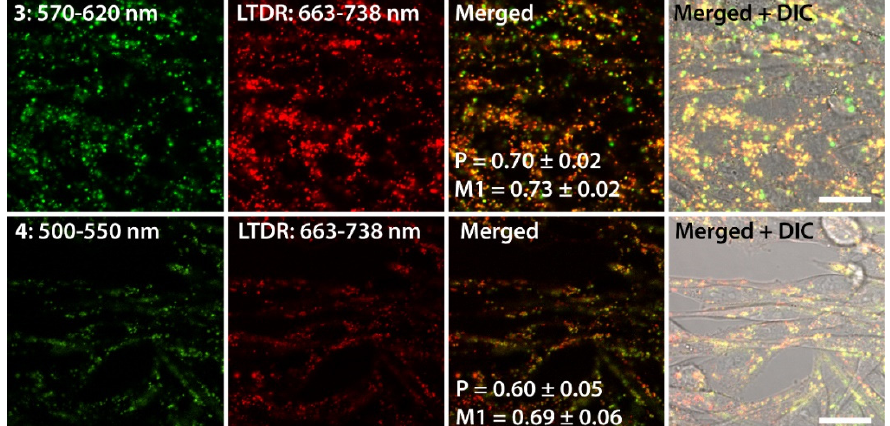
Figure 9. Co-staining of CHO-K1 cells with complexes 3 (5 µM, 24 h) and 4 (25 µM, 24 h) and Lysotracker Deep Red (50 nM, 30 min). Pearson’s (P) and Mander’s (M1) coefficients are given in the merged picture.